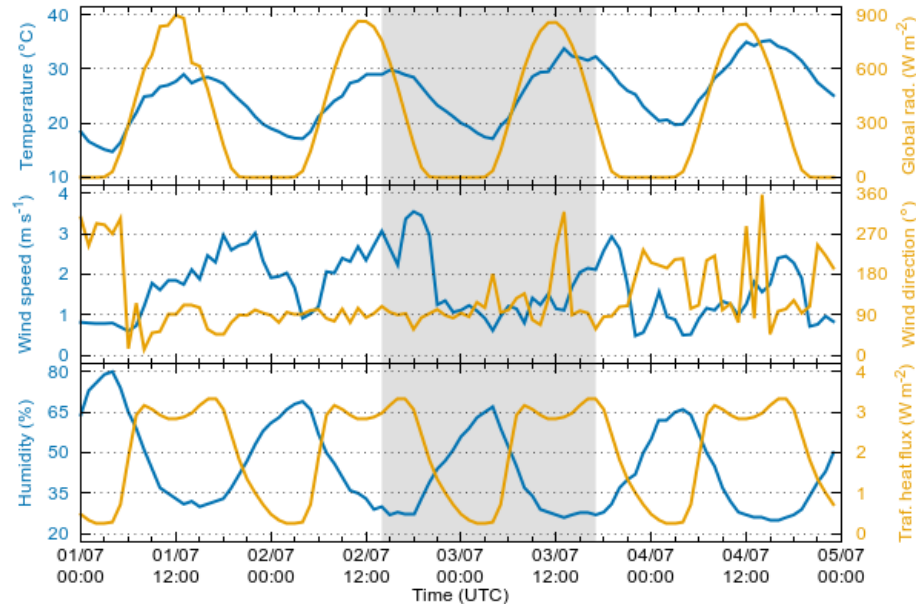
Figure 4. Meteorological conditions from station Prague, Karlov, and spatially averaged traffic heat flux from 1 to 4 July. The shaded area marks the time of the observation